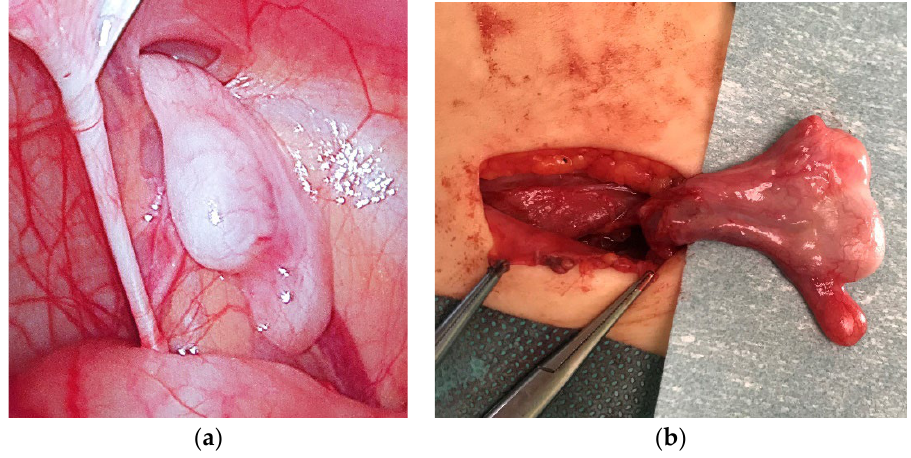
Figure 1. A boy with unpalpable right testis: ( a ) diagnostic laparoscopy at 9 months of age—an intra-abdominal testis with a separation of caput epididymis is visible; ( b ) the same testis during canalicular orchiopexy at 16 months of age (second stage of Fowler–Stephens operation).